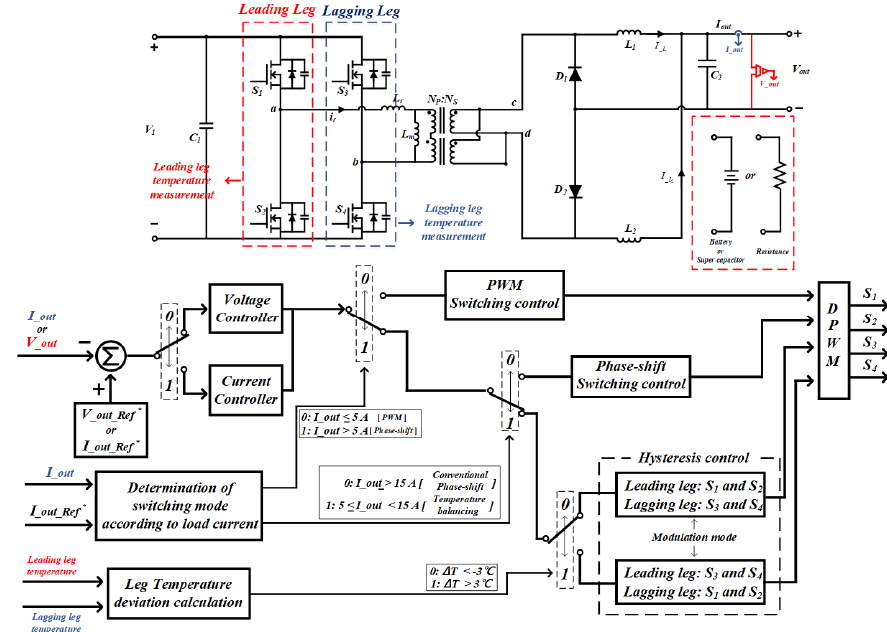
Figure 5. Block diagram of the proposed full-bridge control method.